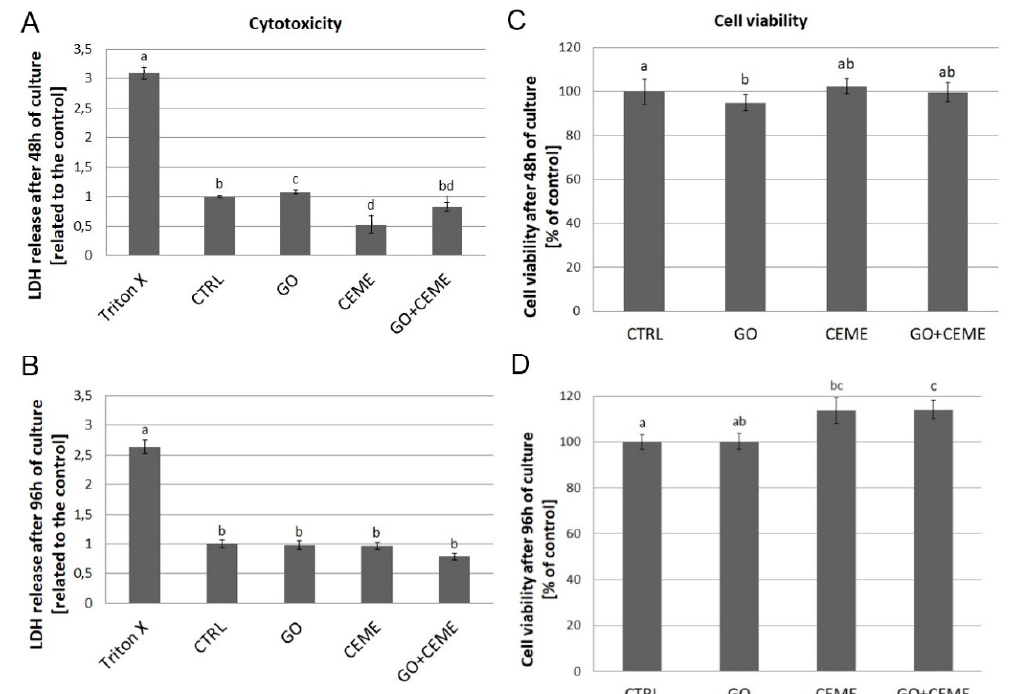
Figure 5. Lactate dehydrogenase (LDH) release ( A , B ) and cell viability ( C , D ) were determined using LDH and MTT assays, respectively. Tests were performed after 48 and 96 h of primary culture. Negative control for LDH maximum release (Triton X), control group (CTRL), cells cultured on graphene oxide nanofilm (GO), cells cultured with addition of the extract (CEME), and cells cultured on GO nanofilm with addition of the extract (GO + CEME). The error bars represent standard deviations. Di ff erent letters (a, b, c, d) above the columns indicate statistically significant di ff erences between the groups ( p ≤ 0.05).